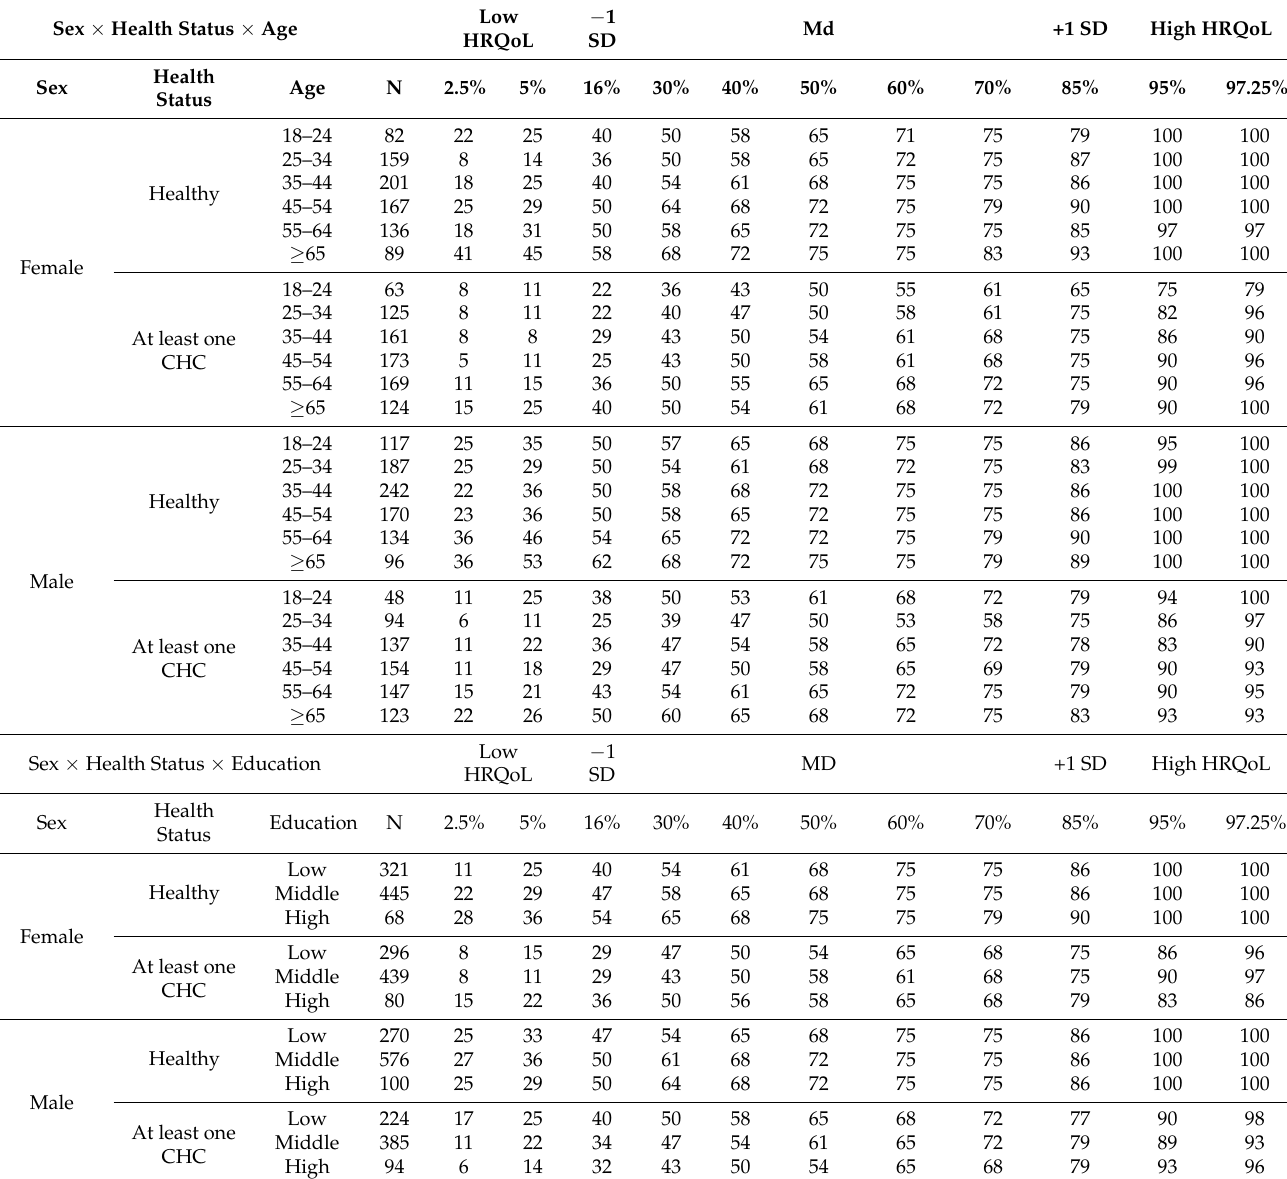
Table A5. Reference values for the QOLIBRI Self scale obtained from the general population sample in Italy stratified by sex, health status, age, and